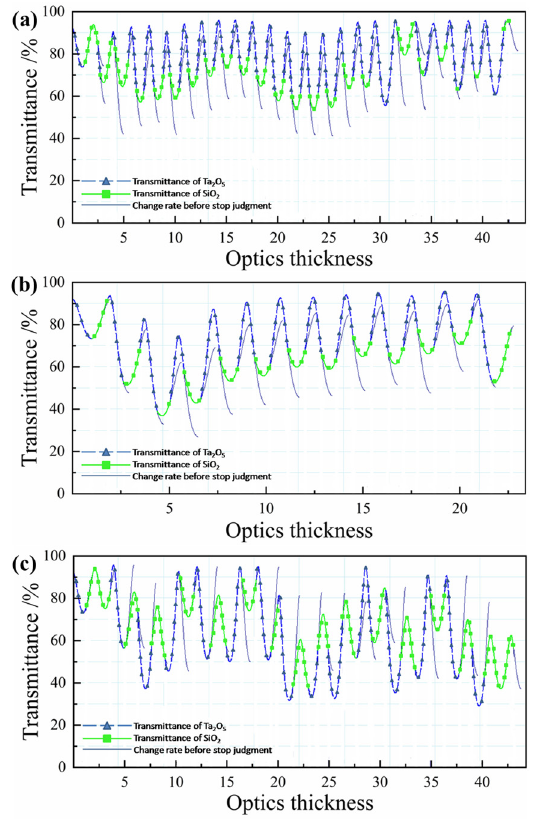
Figure 9. ( a ) Optical monitoring design of the input surface film system. Optical monitoring design of output surface film system ( b ) 1 # and ( c ) 2 # .